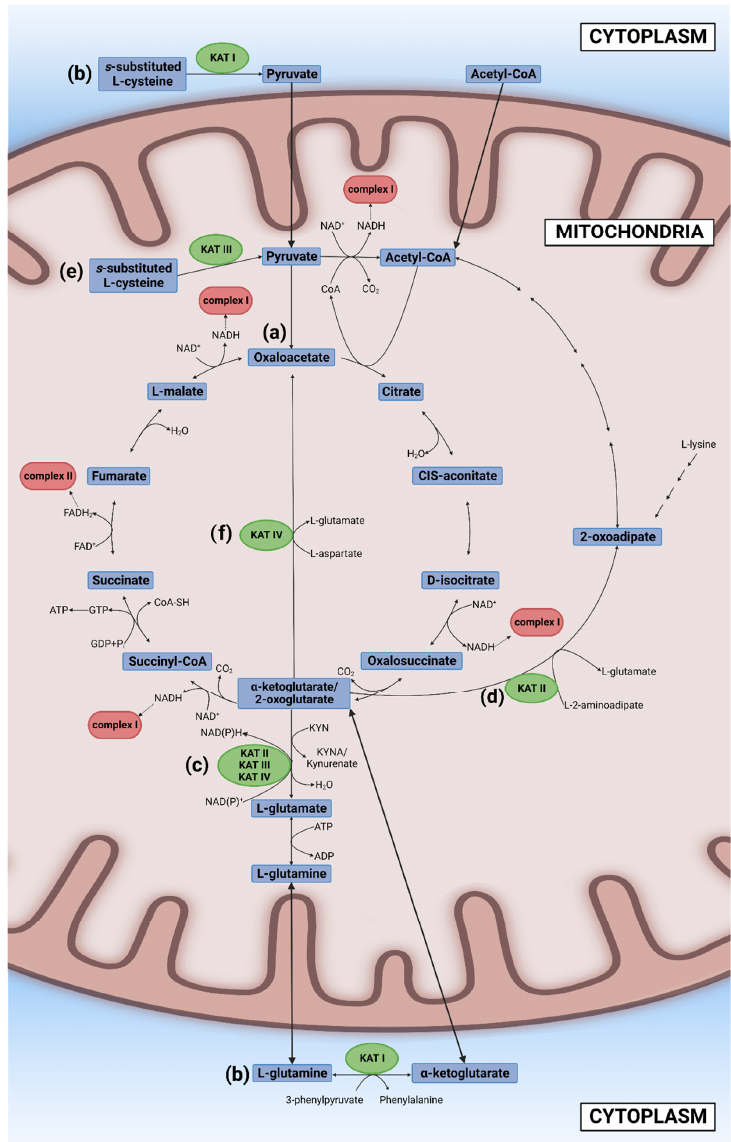
Figure 1. The tricarboxylic acid cycle (TCA) and its interface with the tryptophan (Trp)–kynurenine (KYN) metabolic system. ( a ) The TCAcycle is initiated with acetyl coenzyme A (acetyl-CoA) reacting with oxaloacetate to form citrate. Citrate is oxidized to alpha (α)-ketoglutarate (2-oxoglutarate) with the formation of nicotinamide adenine dinucleotide (NADH). α -ketoglutarate is oxidized to succinyl coenzyme A (succinyl-CoA) with the formation of NADH. Succinyl-CoA is converted to succinate with the formation of adenosine triphosphate (ATP). Succinate is oxidized to fumarate with the formation of flavin adenine dinucleotide (FADH 2 ). Fumarate is hydrated to malate which is oxidized to oxaloacetate to end the cycle. ( b ) Cytosolic kynurenine aminotransferase (KAT) I catalyzes the reaction of an S -substituted L-Cys to pyruvate. KAT I also catalyzes the reaction of L-glutamine to α -ketoglutarate (2-oxoglutarate). ( c ) Mitochondrial KAT II, KAT III, and KAT IV catalyze the reaction of α -ketoglutarate (2-oxoglutarate) to L-glutamate. ( d ) KAT II catalyzes the reaction of α -ketoglutarate (2-oxoglutarate) to 2-oxoadipate which is eventually degraded to acetyl-CoA. ( e ) Mitochondrial KAT III catalyzes the reaction of an S -substituted L-Cys to pyruvate. ( f ) Mitochondrial KAT IV catalyzes the reaction of α -ketoglutarate (2-oxoglutarate) and L-aspartate to α -ketoglutarate (2-oxaloacetate) and